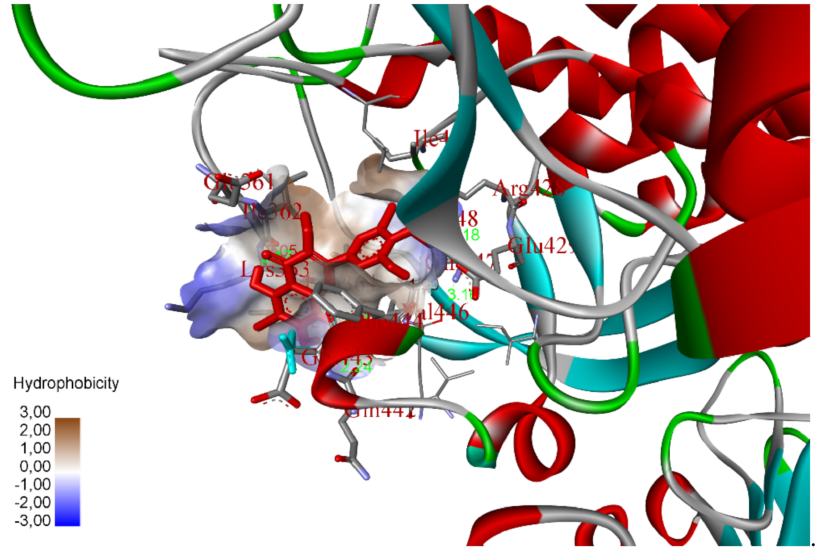
Figure 7. The most stable conformation ligand 8 was bound to active sites on the target enzyme at pocket of 4J5T : PDB (ligand: red